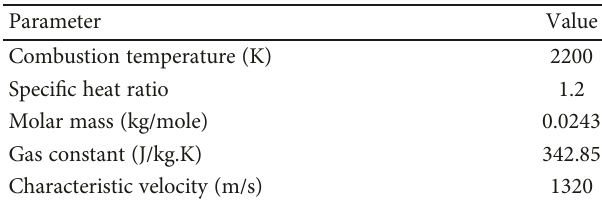
Table 2: Primary properties of combustion